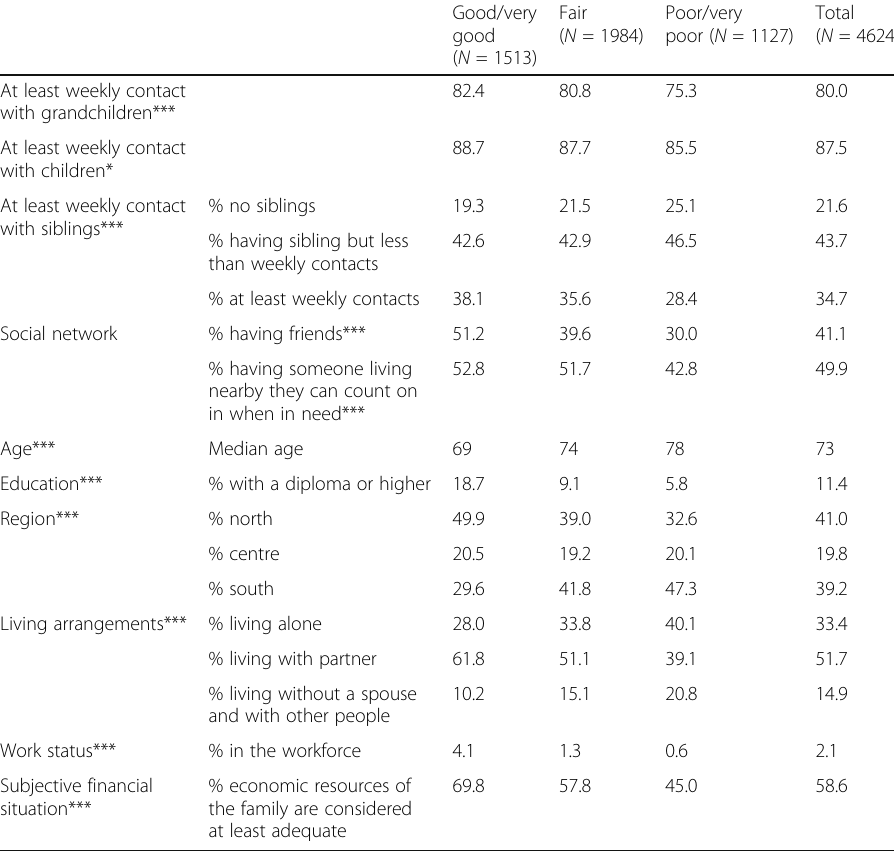
Table 6 Descriptive characteristics of grandmothers ≥ 60 years by self-perceived health status (data are expressed as the percentage, except for age)